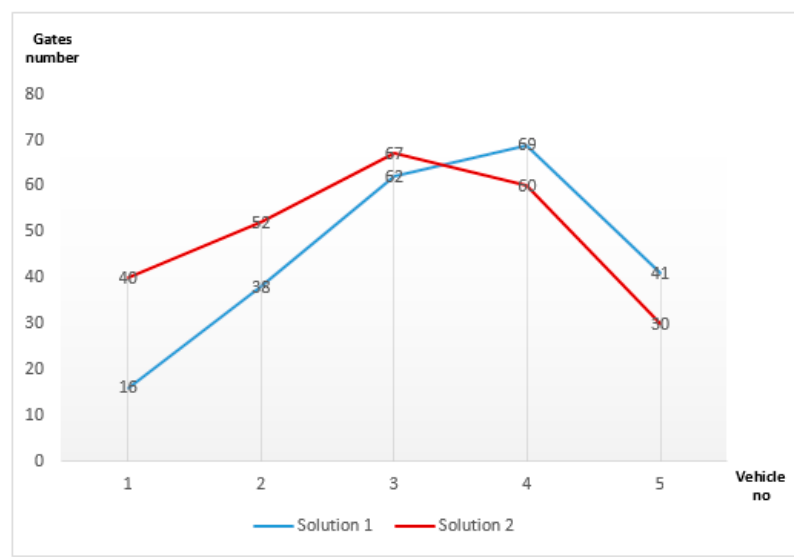
Figure 14. Use of open gates according to the number of vehicles.